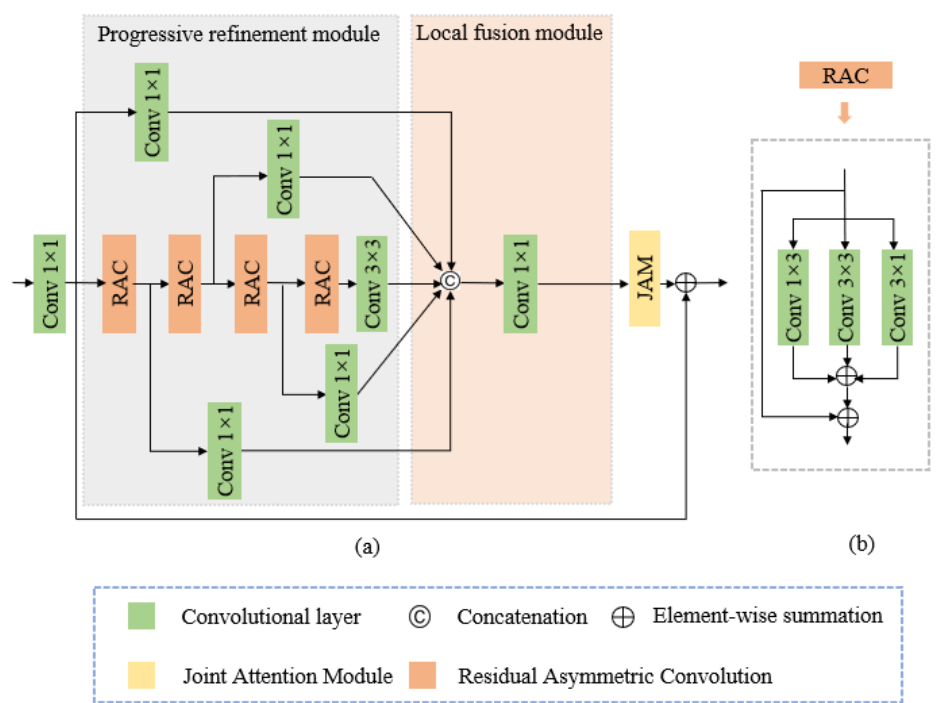
Figure 3. Proposed AFDB design with a four-step distillation example: ( a ) AFBD and ( b ) RAC structures.